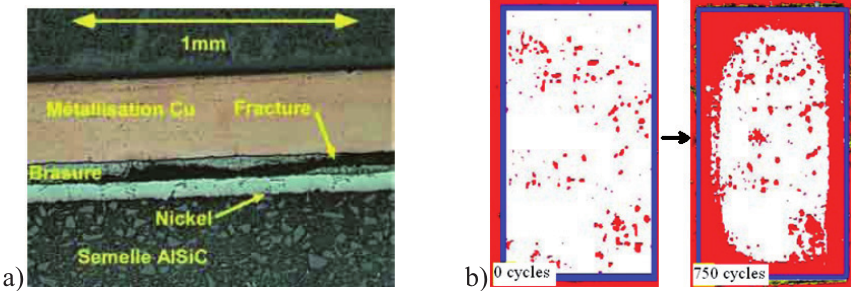
Fig. 3. Base plates solder fatigue fracture (a) [4], and delamination progression (b) [5].